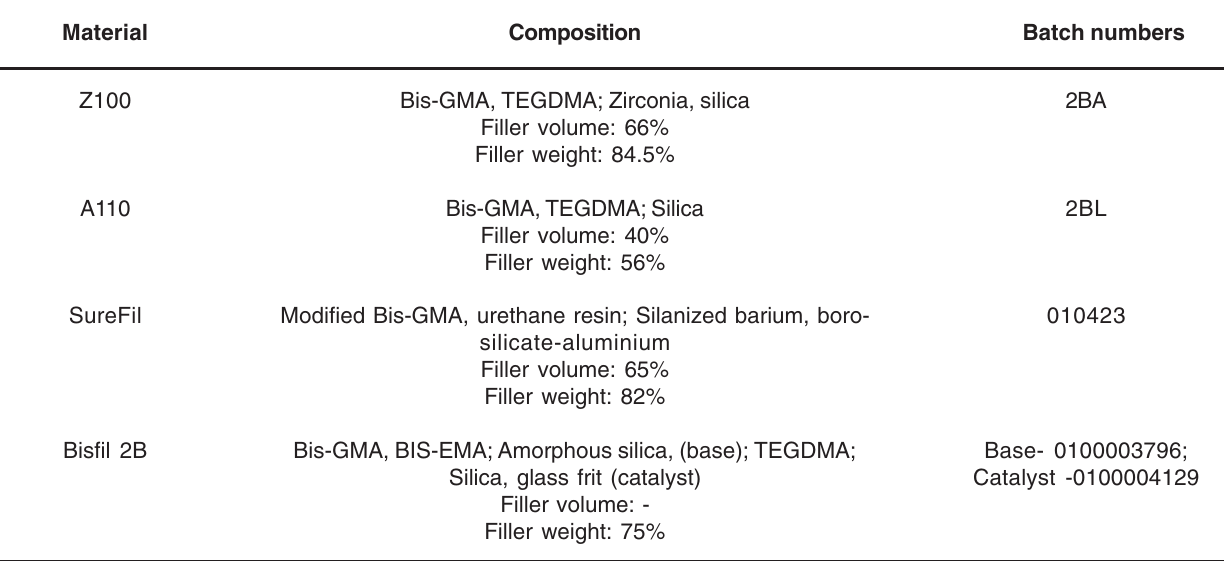
TABLE 1- Description of the composition of the tested restorative composite resins